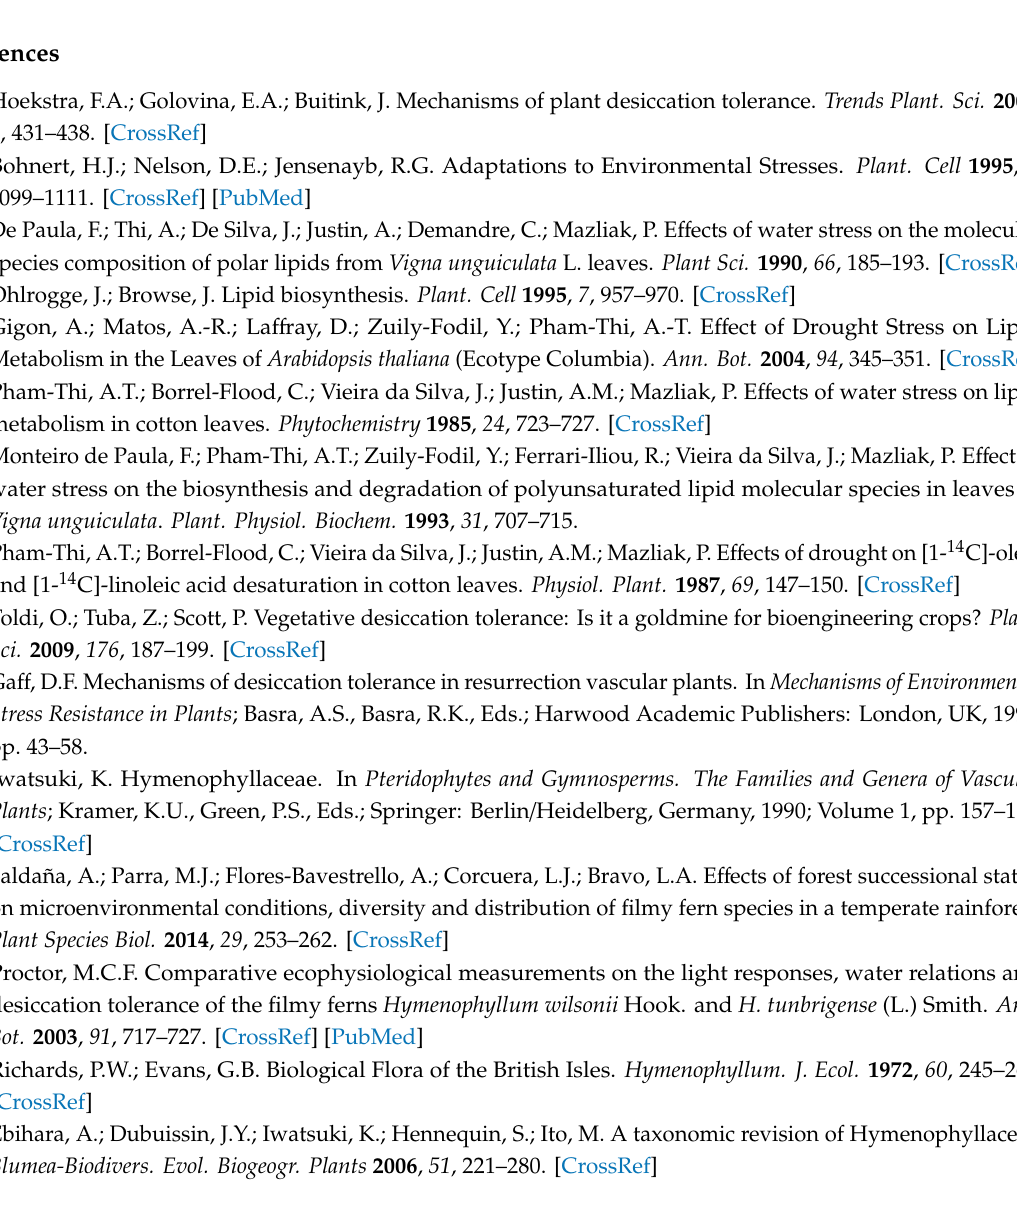
Figure S1: Representative chromatogram of H. plicatum during desiccation–rehydration cycle. Figure S2: Representative chromatogram of H. caudiculatum during desiccation–rehydration